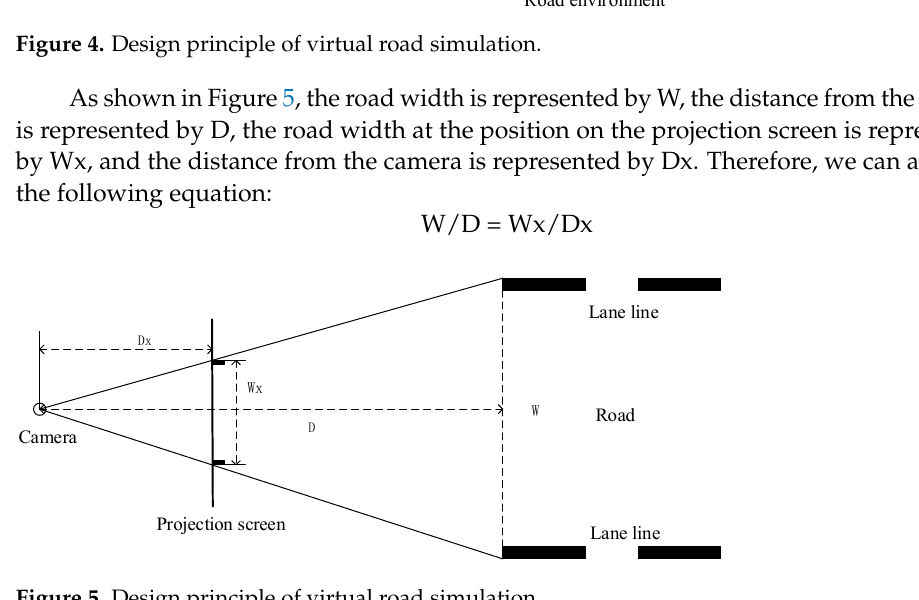
Figure 5. Design principle of virtual road simulation.